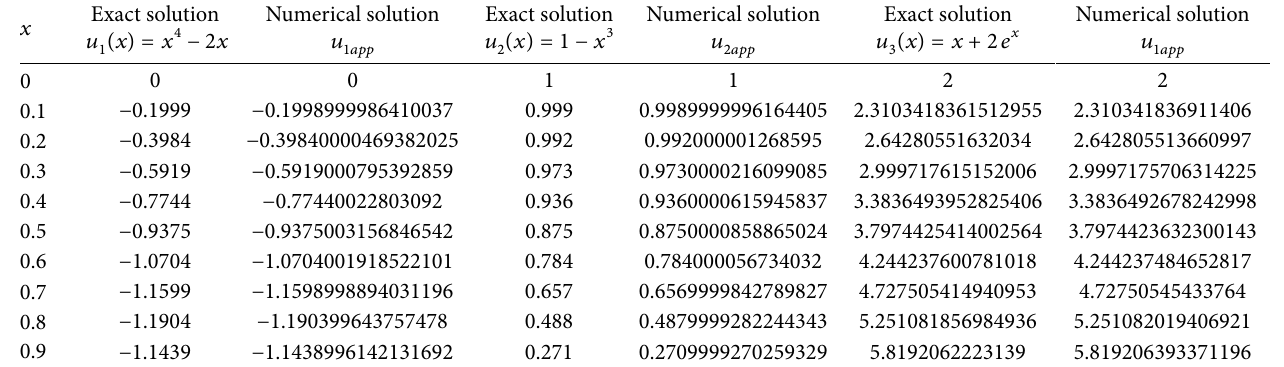
Table 1: The exact and numerical solutions of applying Algorithm 1 for system (66) with